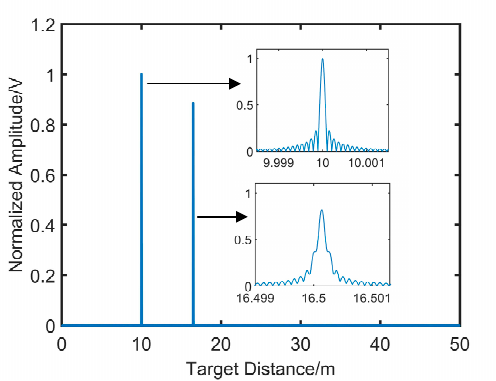
Figure 3. Simulation diagram of the resampling distance